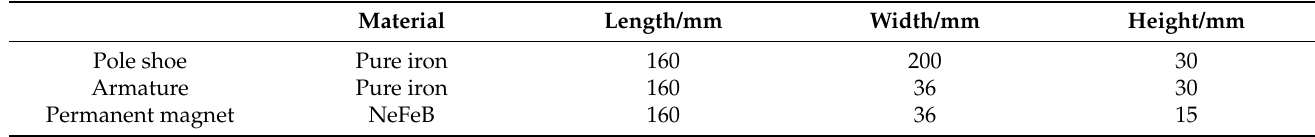
Table 1. The size of the magnetized